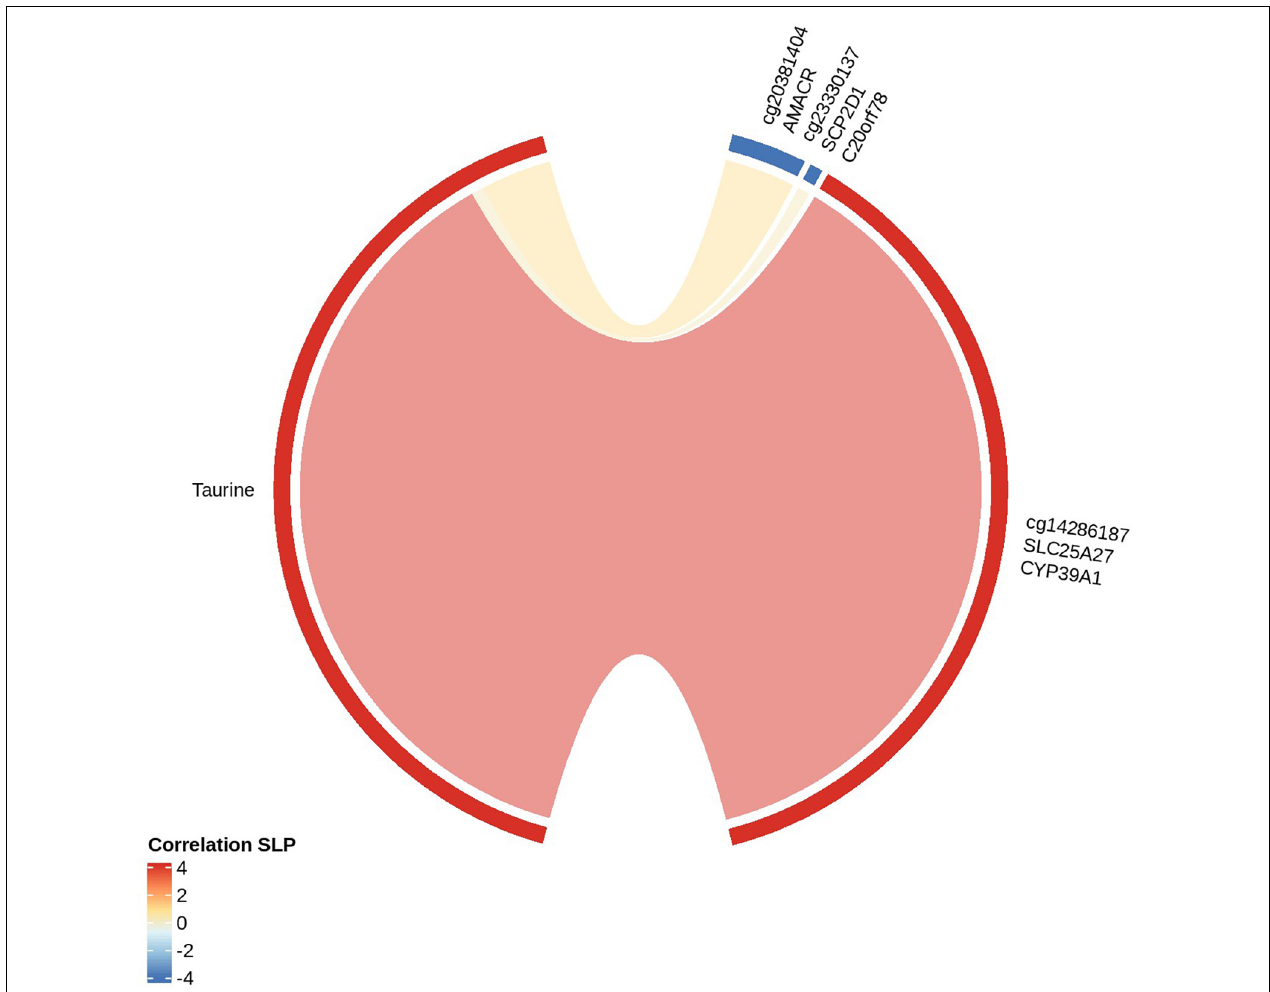
FIGURE 3 | Correlation between significantly differentially methylated cytosines (genes) with metabolites of Primary Bile acid biosynthesis: The red strip around the “circos plot” shows the positive correlation and the blue strip shows the negative correlation. The metabolite correlated with CpGs and the genes encompassed under CpGs are